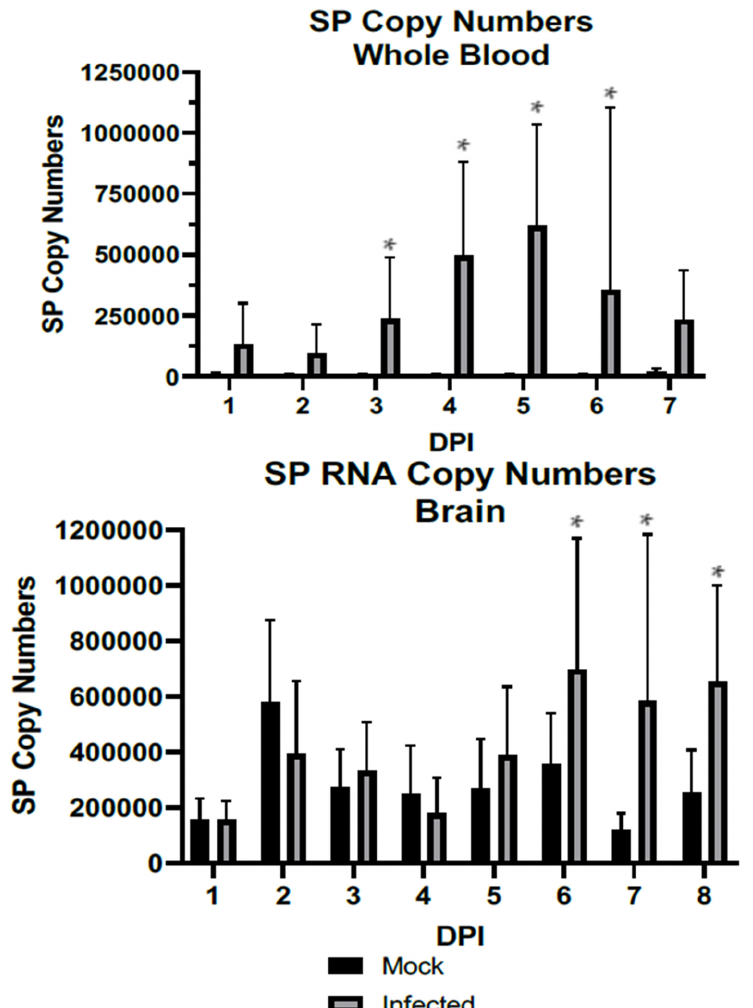
Figure 1. RNA levels of SP as detected by qPCR against a standard curve in whole blood and brain. Top : Whole blood. Bottom : Whole brain tissue homogenate. Error bars represent the standard deviations. Significant differences between WNV-infected and mock mice were detected within 3 DPI ( p = 0.0092) and remained significant at 4 DPI ( p = 0.0007), 5 DPI ( p = 0.0009), and 6 DPI (0.0012), while SP copy numbers’ increases in the brain are not detectable until 6 DPI ( p = 0.0031). N = 10 per group per day, and N = 18 WNV-infected mice are included in the analyses of D6 and D7 due to early attrition. *: p < 0.01.